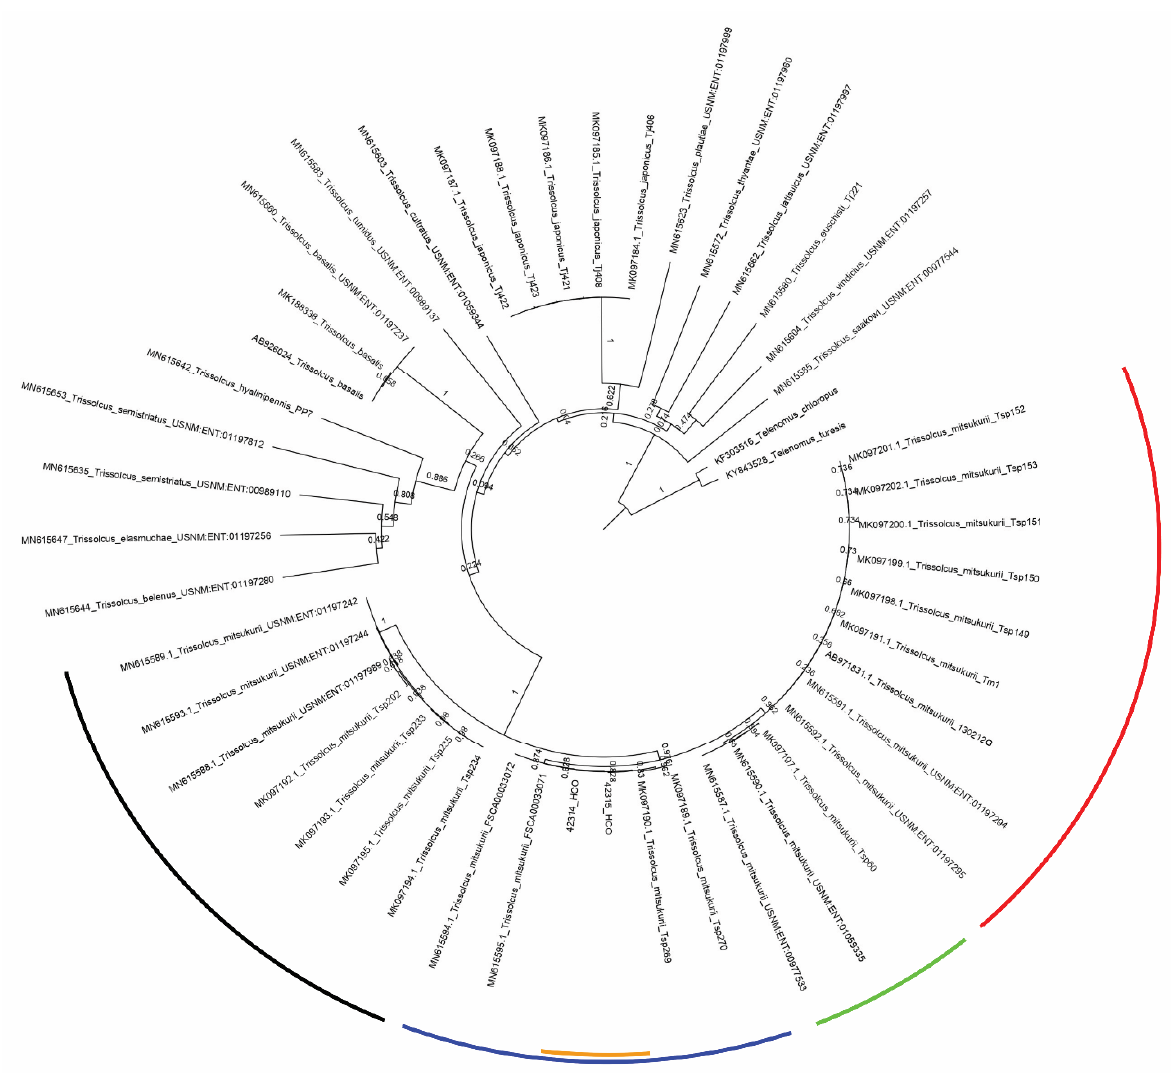
Figure 2. Molecular clustering of 48 sequences including the Trissolcus mitsukurii French individuals. All sequences of T. mitsukurii available in GenBank were used as some reference sequences of other Trissolcus species. Telenomus turesis Walker and Te. chloropus (Thomson) were used as out-group. Origins of T. mitsukurii are highlighted by colours: Japan in red, China in green, South Korea in black, Italy in blue, and French in orange.